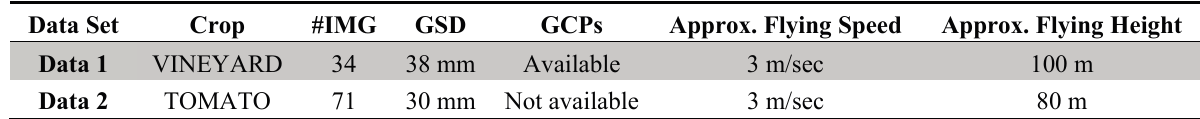
Table 4. Fieldwork sites and acquired images. The high flying height and the quite low flying speed helped to reduce the effects of the camera rolling